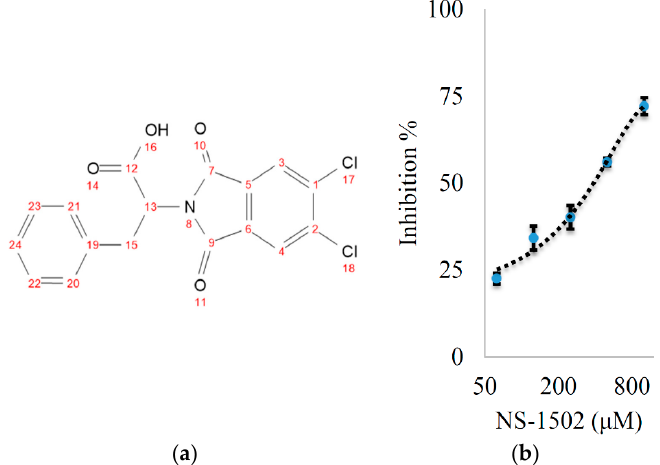
Figure 4. ( a ) Structure of NS-1502 with numbering corresponding to the NMR results; ( b ) Inhibitory activity of NS-1502 in a dose-dependent format.